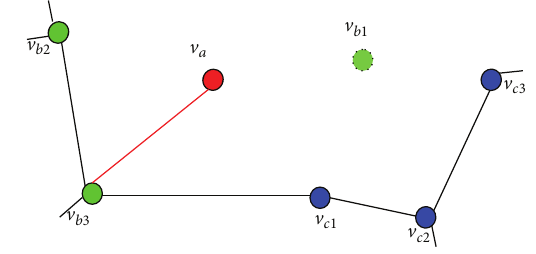
Figure 5: Load distribution when node is restored.